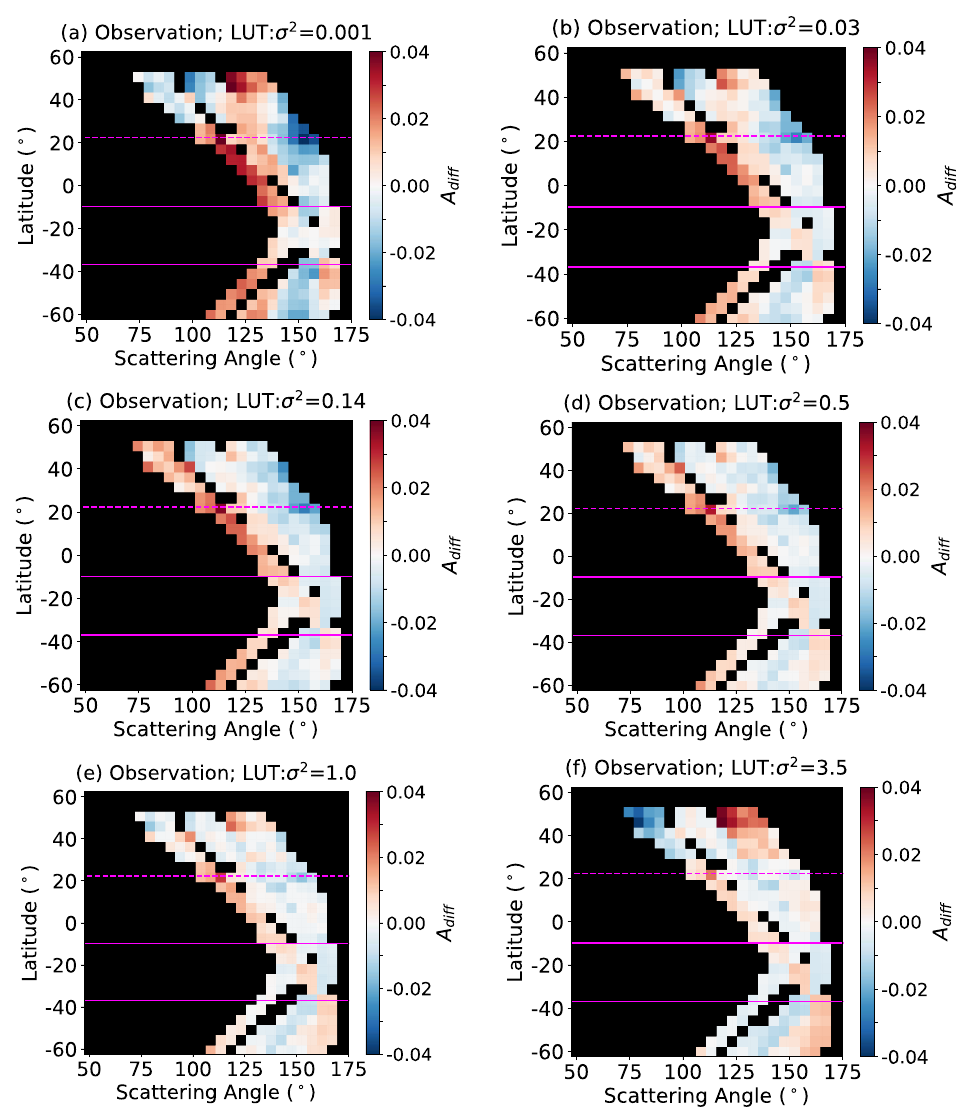
Figure 8. The same as Figure 4 but computed for thick homogeneous clouds only. The A dif f value in latitude-scattering angle bins on December solstices from 2012 to 2015 using ( a ) R0001, ( b ) R003, ( c ) R014, ( d ) R05, ( e ) R10, and ( f ) R35 ice particle models. The dashed and solid lines correspond to SZA 50 ◦ and 30 ◦ , respectively.